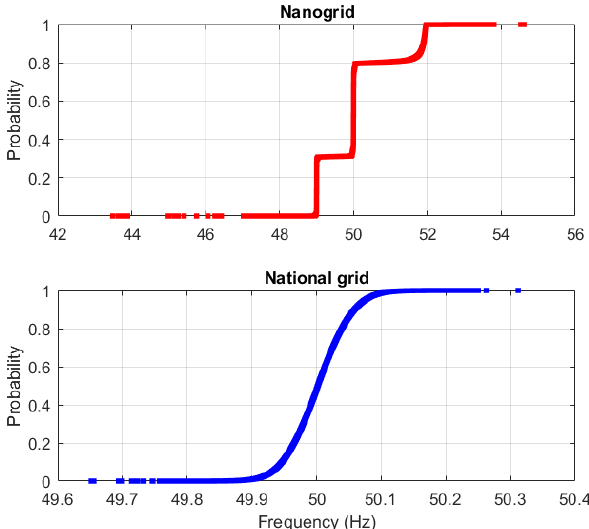
Figure 2. CDF for the 48 weeks of 10 s average frequency values in the nanogrid during islanded operation ( top ) and a corresponding CDF ( bottom ) for the 54 weeks of 10 s average frequency values in the nanogrid during grid operation. Note the difference in horizontal scale.